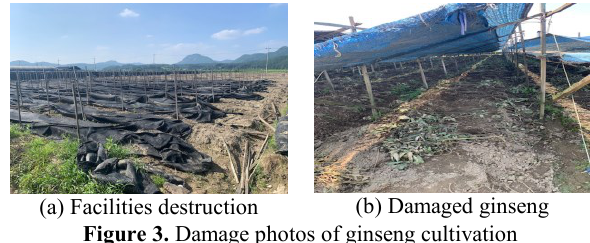
Figure 3. Damage photos of ginseng cultivation